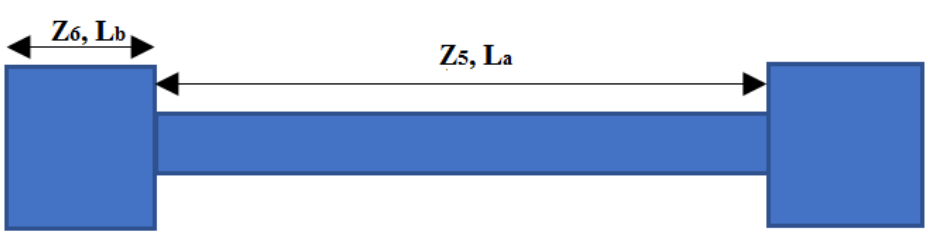
Figure 5. Proposed rectangular stub configuration.